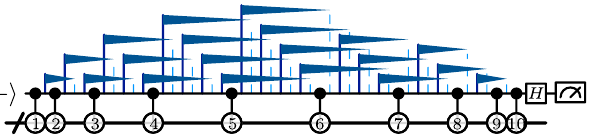
FIG. 3. Optimized ( t = 2 ) -FT circuit for measuring X ⊗ 10 . Note that the central data CNOT gates are protected by 2 t flags, but fewer flags are used toward the ends. With appropriate correction rules, the circuit tolerates up to two faults.